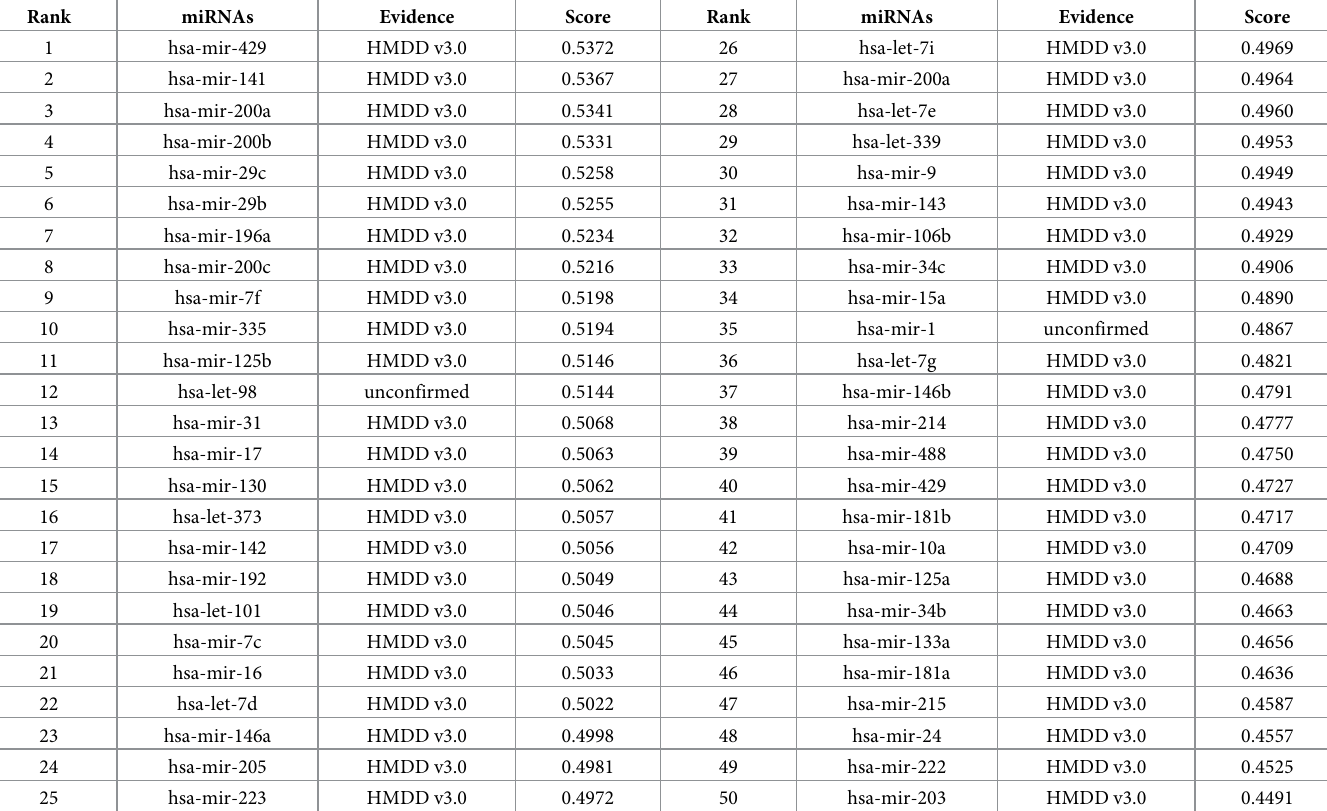
Table 6. Validation results of predicted associations for breast cancer as an unknown